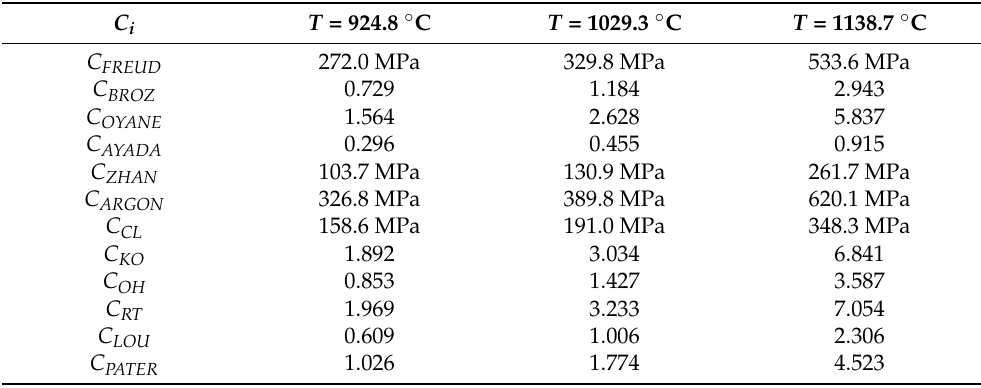
Figure 17. Dimensionless damage functions in the axial zone of the specimen in the CWR test, with T 0 = 1000 ◦ C (the axial coordinate X = 0 mm denotes symmetry plane). Table 1. Critical damage of 42CrMo4 grade steel depending on the forming temperature T (assuming that T = T av ), as determined in the CWR